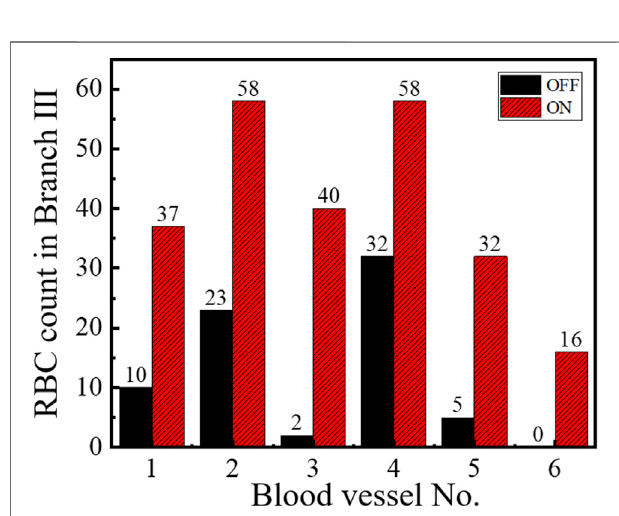
FIGURE 3 | RBCs count of reperfusion in six different branching microvessels within 10 s.